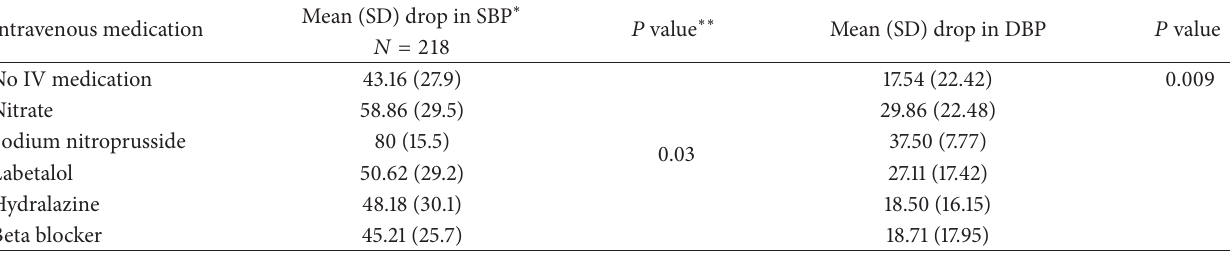
Table 3: Mean drop in systolic and diastolic blood pressure in ER in patients with hypertensive crisis according to type of intravenous